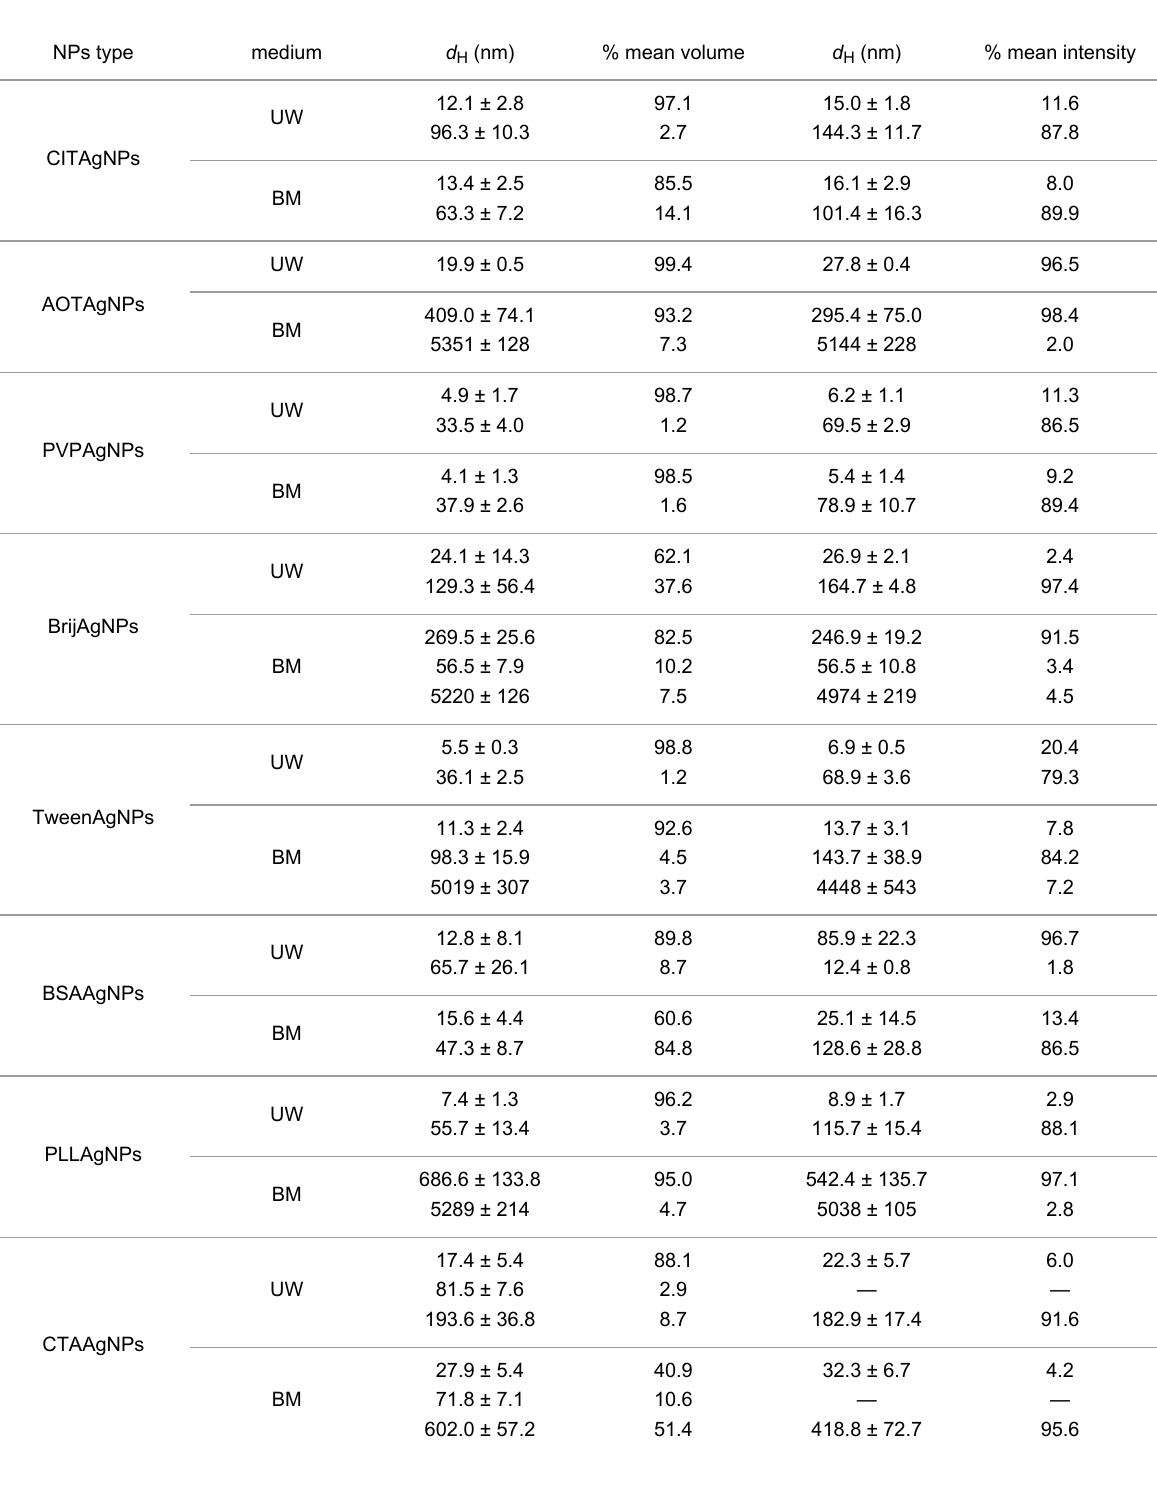
Table 1: Hydrodynamic diameter ( d H ) obtained from size distributions by volume and intensity of differently coated silver nanoparticles in ultrapure water (UW) and biological medium (BM) after 1 h at 25 °C. Coating agents: trisodium citrate (CITAgNP), sodium bis(2-ethylhexyl) sulfosuccinate (AOTAgNP), poly(vinylpyrrolidone) (PVPAgNP), Brij 35 (BrijAgNP), Tween 20 (TweenAgNP), bovine serum albumin (BSAAgNP), poly(L-lysine) (PLLAgNP), and cetyltrimethylammonium bromide